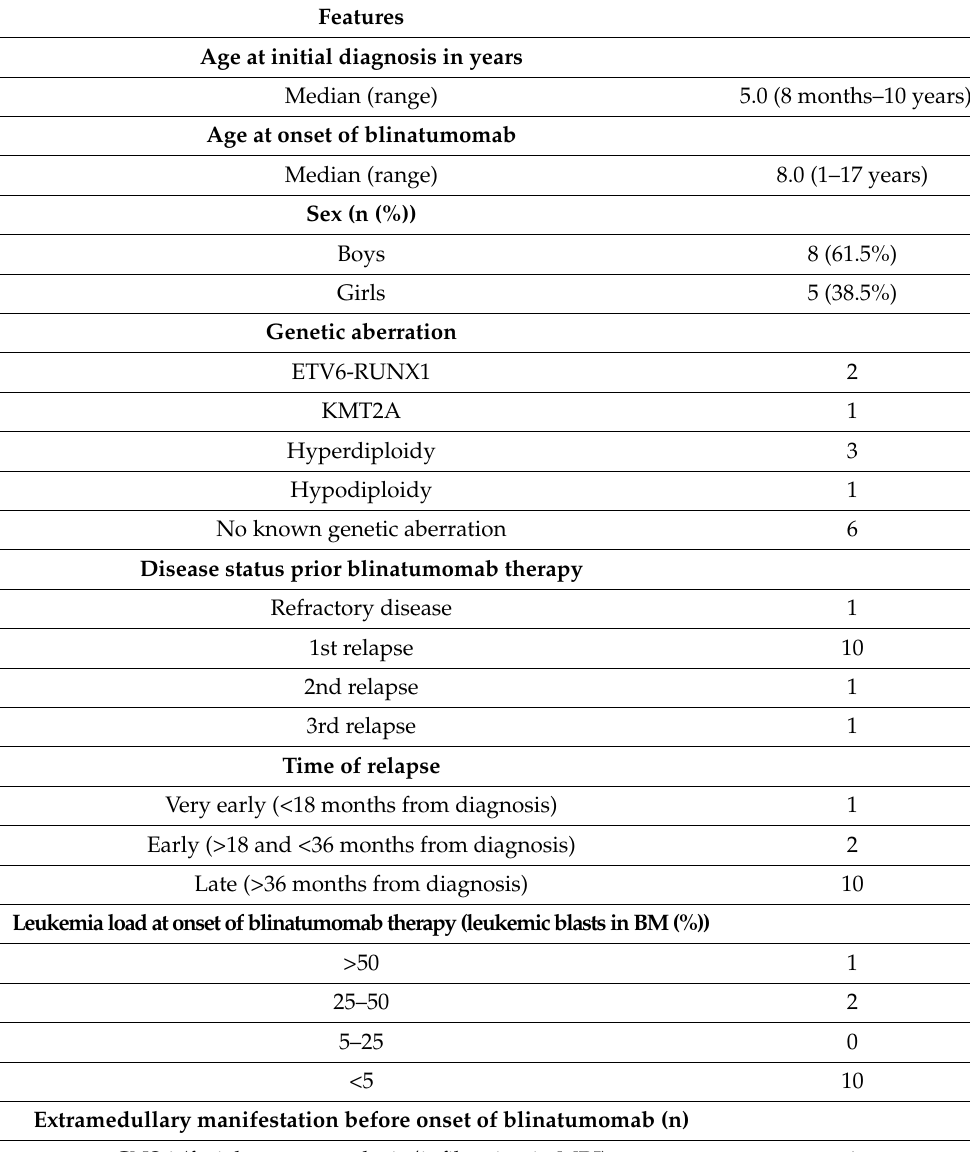
Table 1. Patient’s